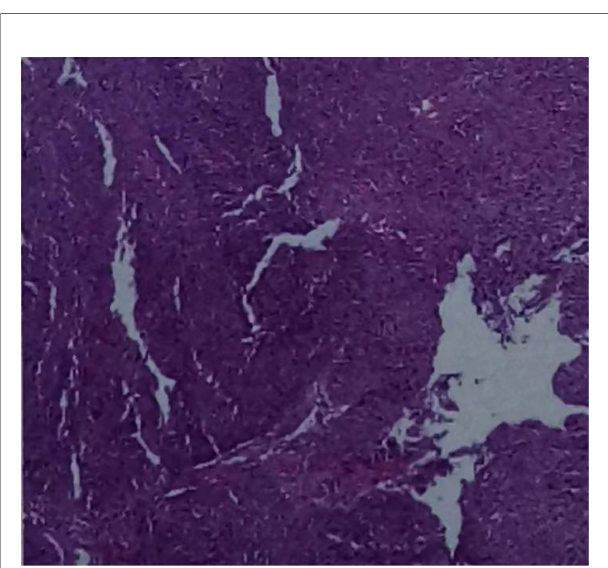
FIGURE 3 | Positron emission tomography/computed tomography (PET/CT) examination showed that: (a) the right hypopharyngeal wall was thickened with increased metabolism, hypopharyngeal cancer was considered, (b) the esophageal wall was limited to hypermetabolic foci at the level of the thoracic 6-10 vertebral body, which was considered esophageal carcinoma, in fi ltrated to the plasma membrane layer and involved the gastric cardia, (c) the right submandibular hypermetabolic lymph node, the small lymph nodes adjacent to the lower esophagus and the gastric cardia had slightly higher metabolism,